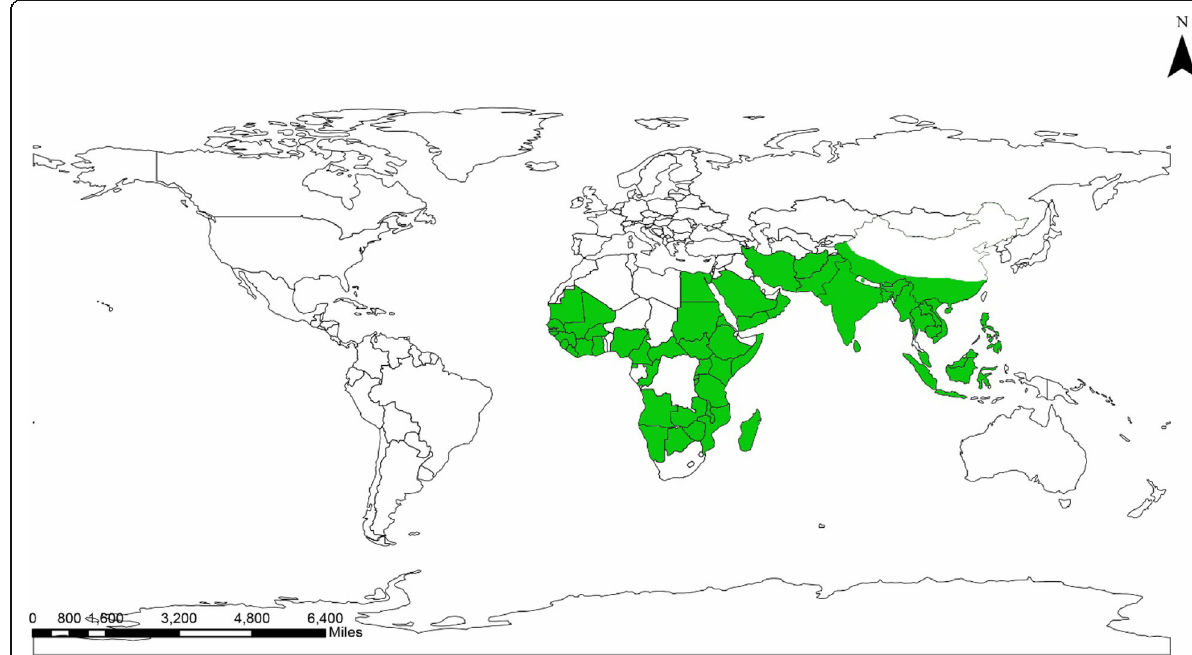
Fig. 1 Distribution of P. daemia in Asia and Africa